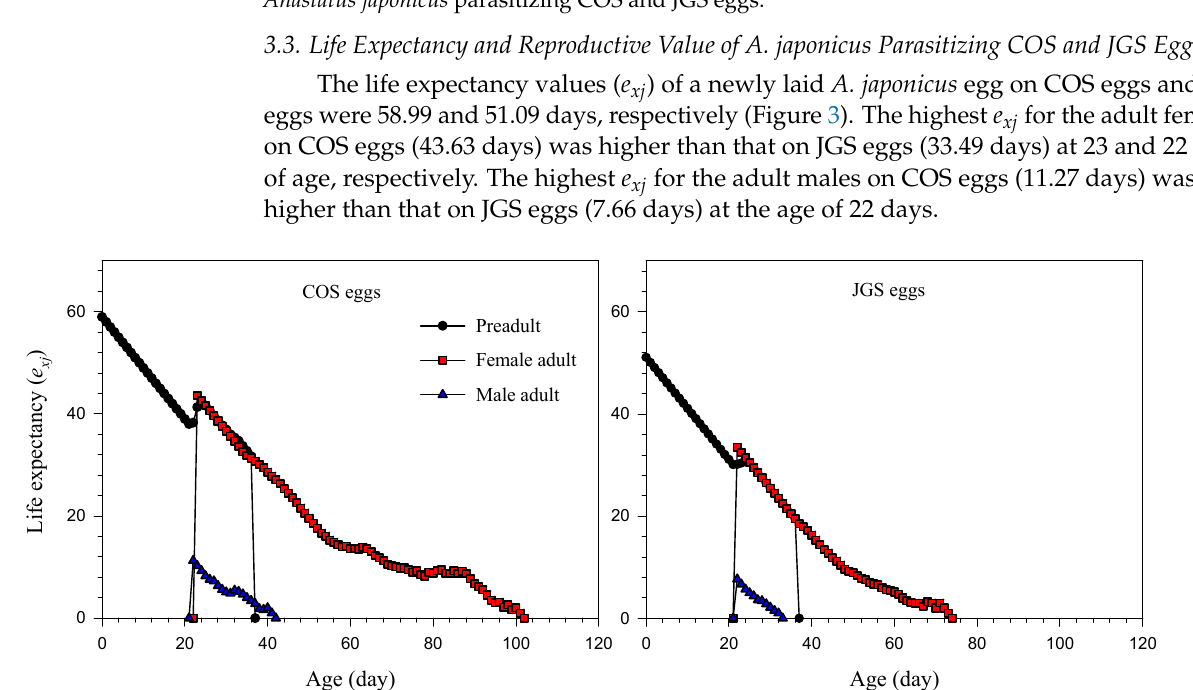
Figure 4. Reproductive values ( v xj ) of Anastatus japonicus parasitizing COS and JGS eggs. 3.4. Population Parameters of A. japonicus Parasitizing COS and JGS Eggs The population demographic parameters of A. japonicus parasitizing COS and JGS eggs are shown in Table 2. The net reproduction rate ( R 0 ), intrinsic rate of increase ( r ), finite rate of increase ( λ ), and mean generation time ( T ) of A. japonicus parasitizing COS eggs were all significantly higher than those parasitizing JGS eggs. There were significant differences in the numbers of female and male offspring produced between parasitoids parasitizing COS eggs and JGS eggs. The net non-reproductive parasitism rate ( G 0 ) on COS eggs was zero. The total net parasitism rate ( P 0 ) (that was the sum of female and male offspring and the net non-reproductive parasitism) was higher on the COS than JGS eggs. The transformation rate ( Q p ) was significantly lower on the COS than JGS eggs.